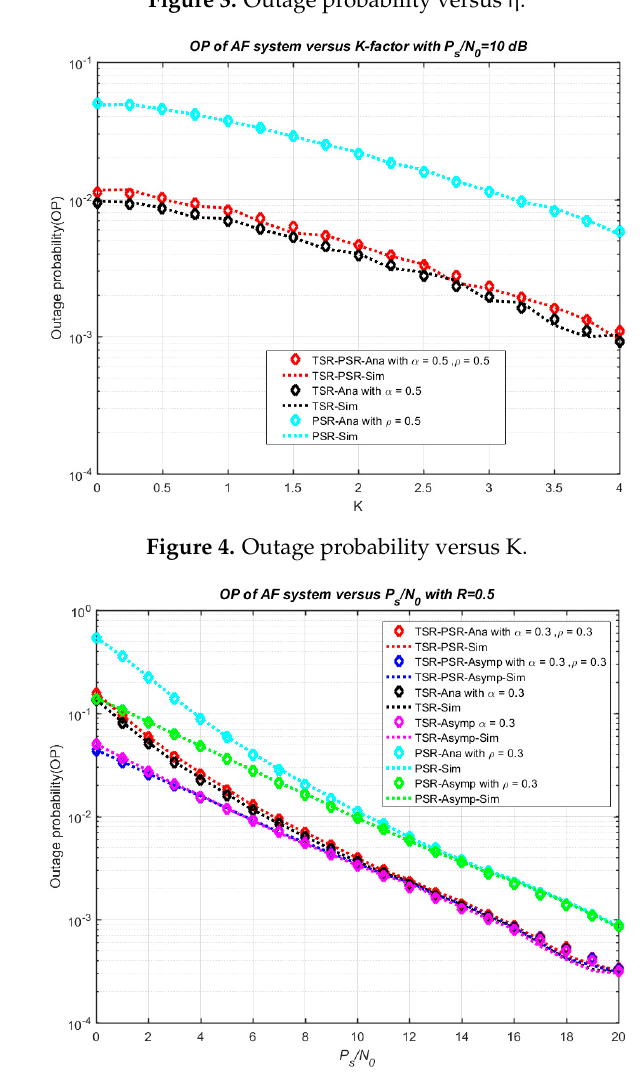
Figure 5. Outage probability versus P s / N 0 .